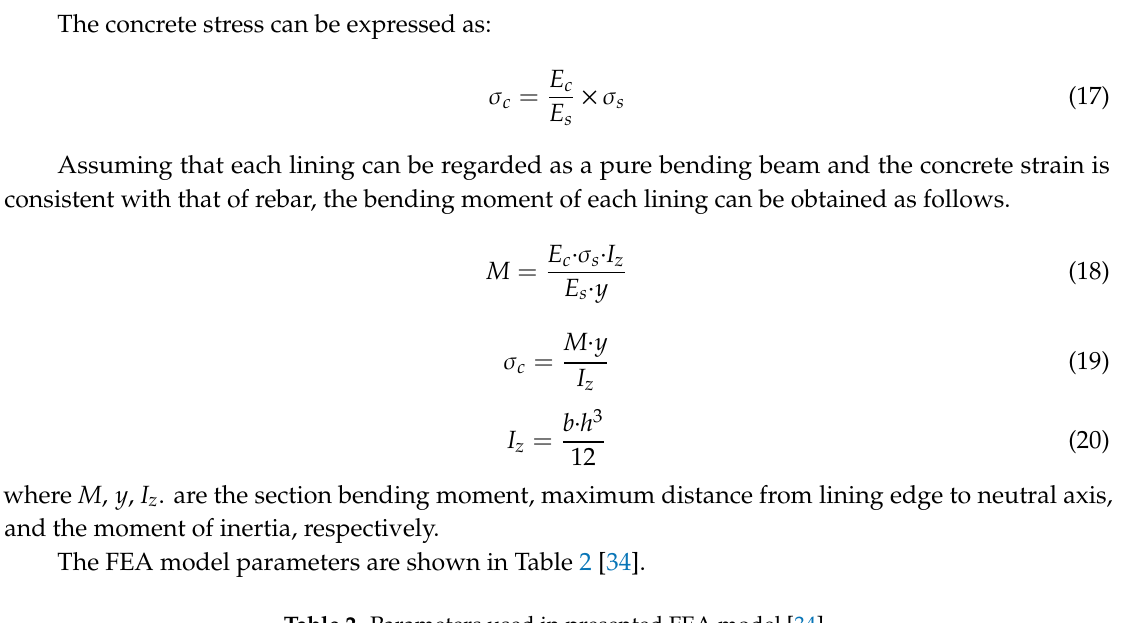
Table 2. Parameters used in presented FEA model